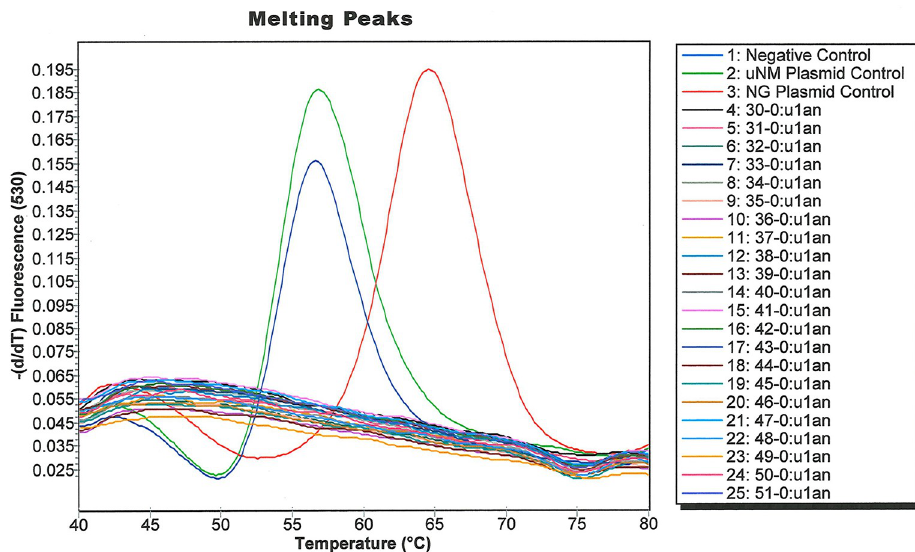
Fig 5. Amplification curve of one IUMP participant who tested positive for uNM in a separate group of 20 men.